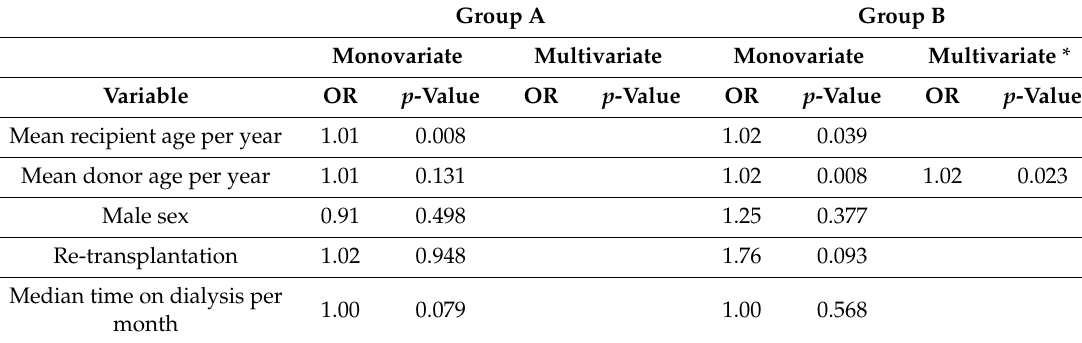
Table 2. Risk factors for lymphocele formation (group A) and treatment (group B) using a logistic regression